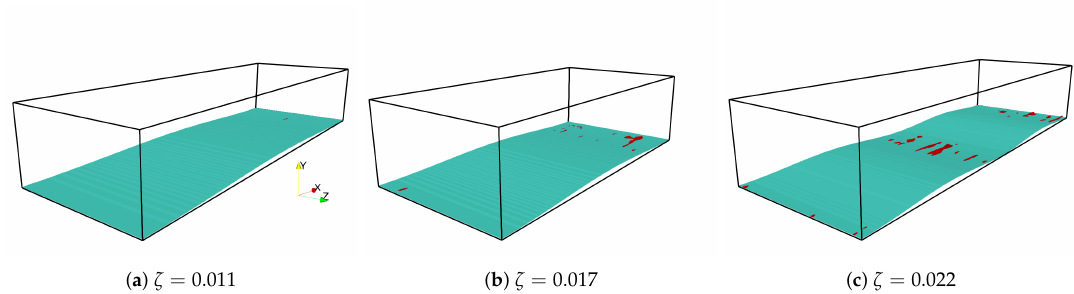
Figure 5. Comparison of instantaneous flow separation for the different wave steepness, ζ . The wavy surface is denoted in cyan and the separation is denoted in red. The coordinate system ( a ) is kept consistent ( b , c